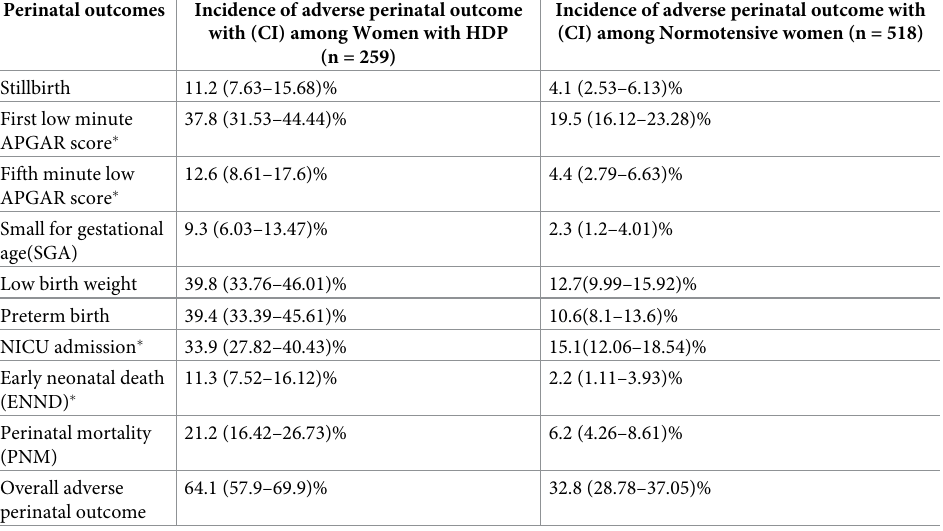
Table 2. Incidence of adverse perinatal outcomes with confidence interval among women with HDP and Normo- tensive women who gave birth at JMC, June, 2017 to March 2020. Perinatal